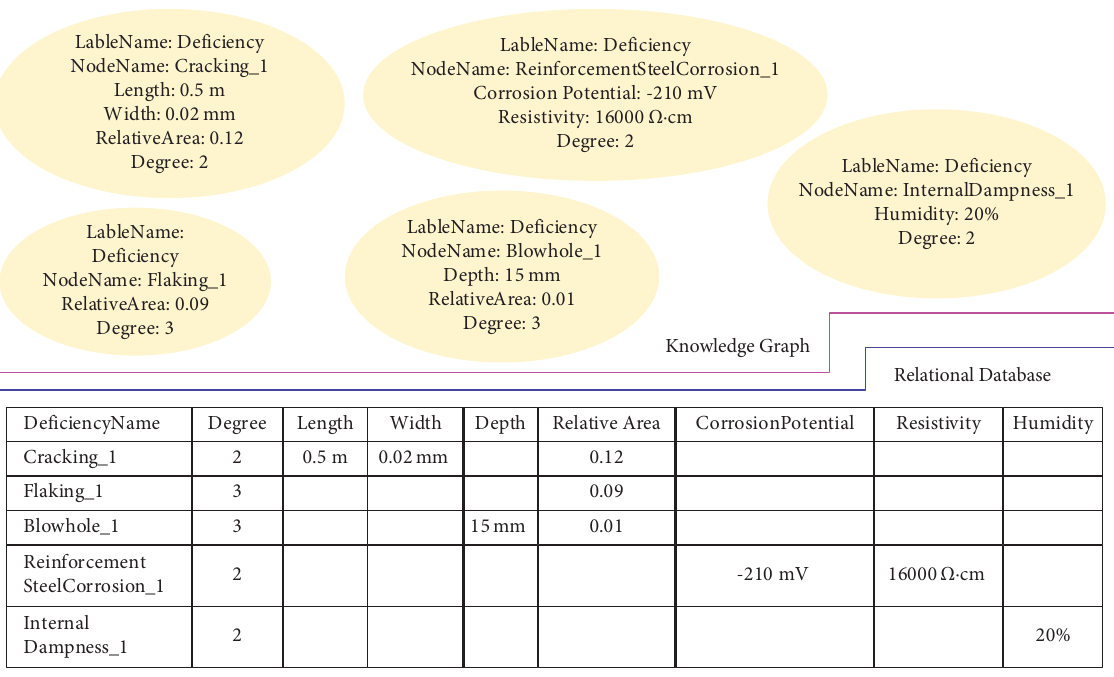
Figure 15: Data sparsity in a relational